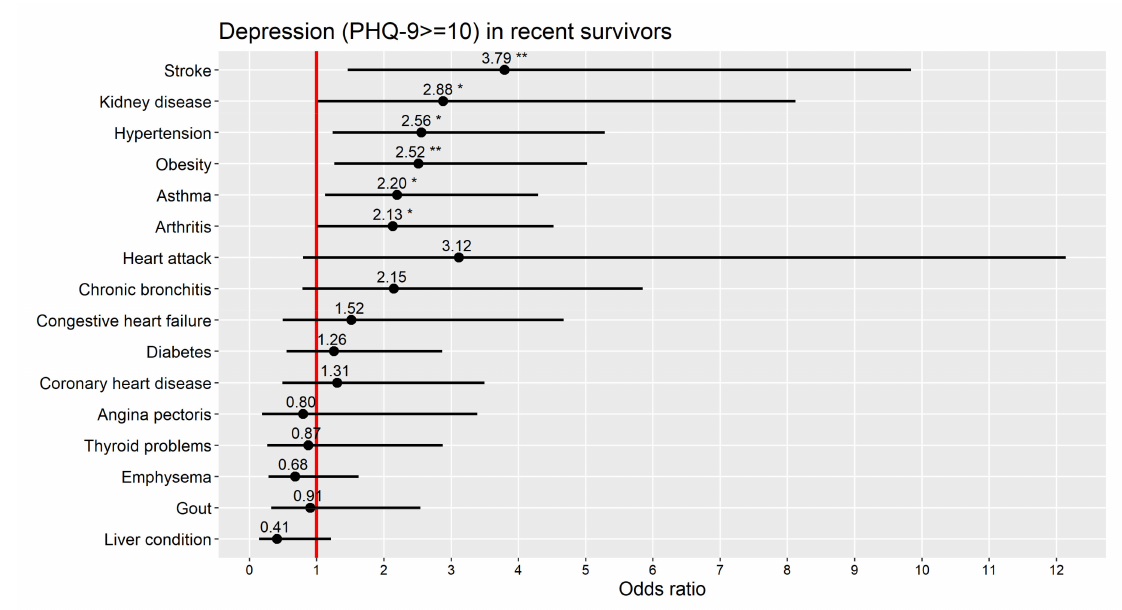
Figure 2. Odds ratios (black dots) and their 95% confidence intervals (black lines crossing the dots) for individual comorbidities from multiple regression analysis in recent survivors with outcome depression (PHQ-9 ≥ 10) and adjusted for age, sex, race, and years since diagnosis. Red line: OR = 1 (no effect). Note: * p ≤ 0.05. ** p ≤ 0.01. * and ** also denote confidence intervals excluding